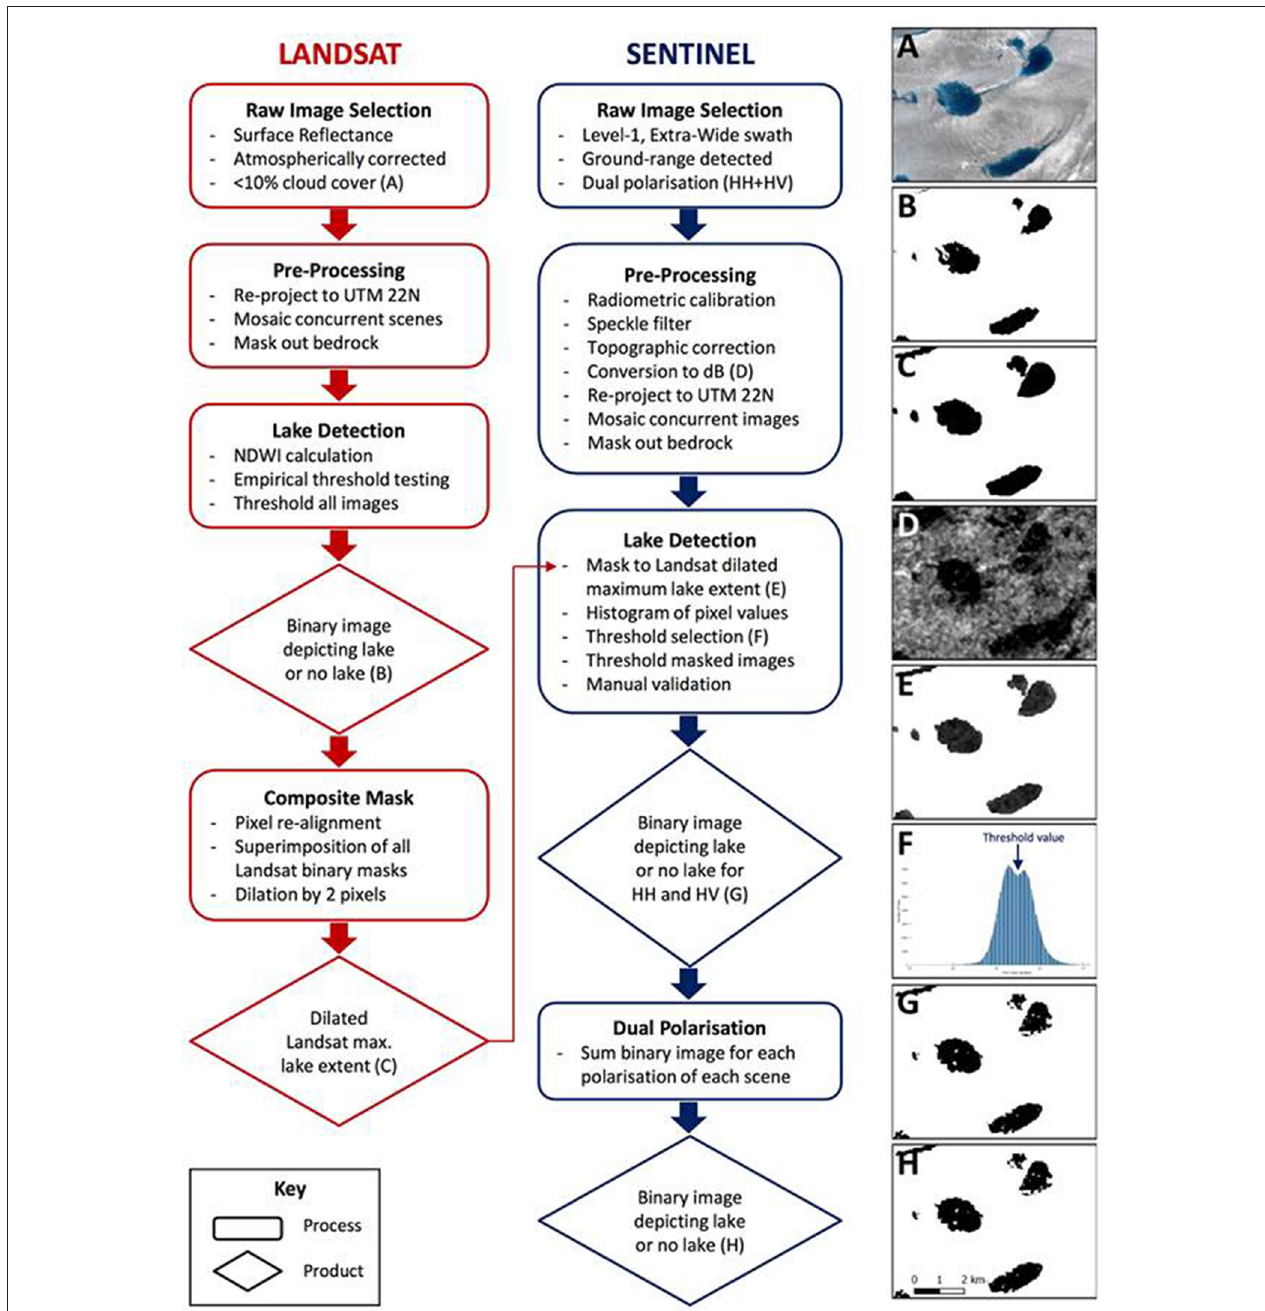
FIGURE 2 | An illustrated flow diagram outlining the methodology followed for both the Landsat and the Sentinel-1 lake detections. Illustrated steps are labeled (A–H) within the diagram and all refer to the same areal extent (shown in Figure 1 ); the Landsat-8 false-color RGB image in (A) and pre-processed HV polarized image shown in (D) were acquired on day 189 (2015).